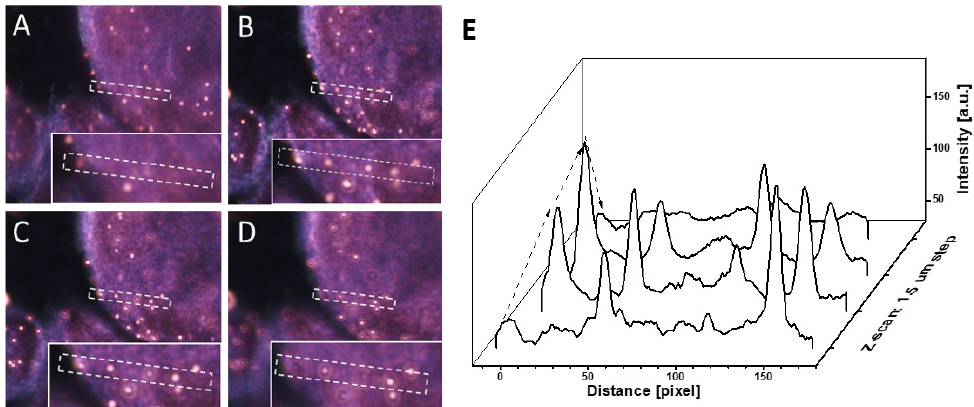
Figure 3. Z-scan of H&E-stained cytology sample labeled with gold spherical NPs (100 nm in diameter). ( A – D ) Images were taken with Nikon 60 × objective (0.7 NA) at 1 µ m step. ( E ) Intensity profile of NPs at different Z focal planes.